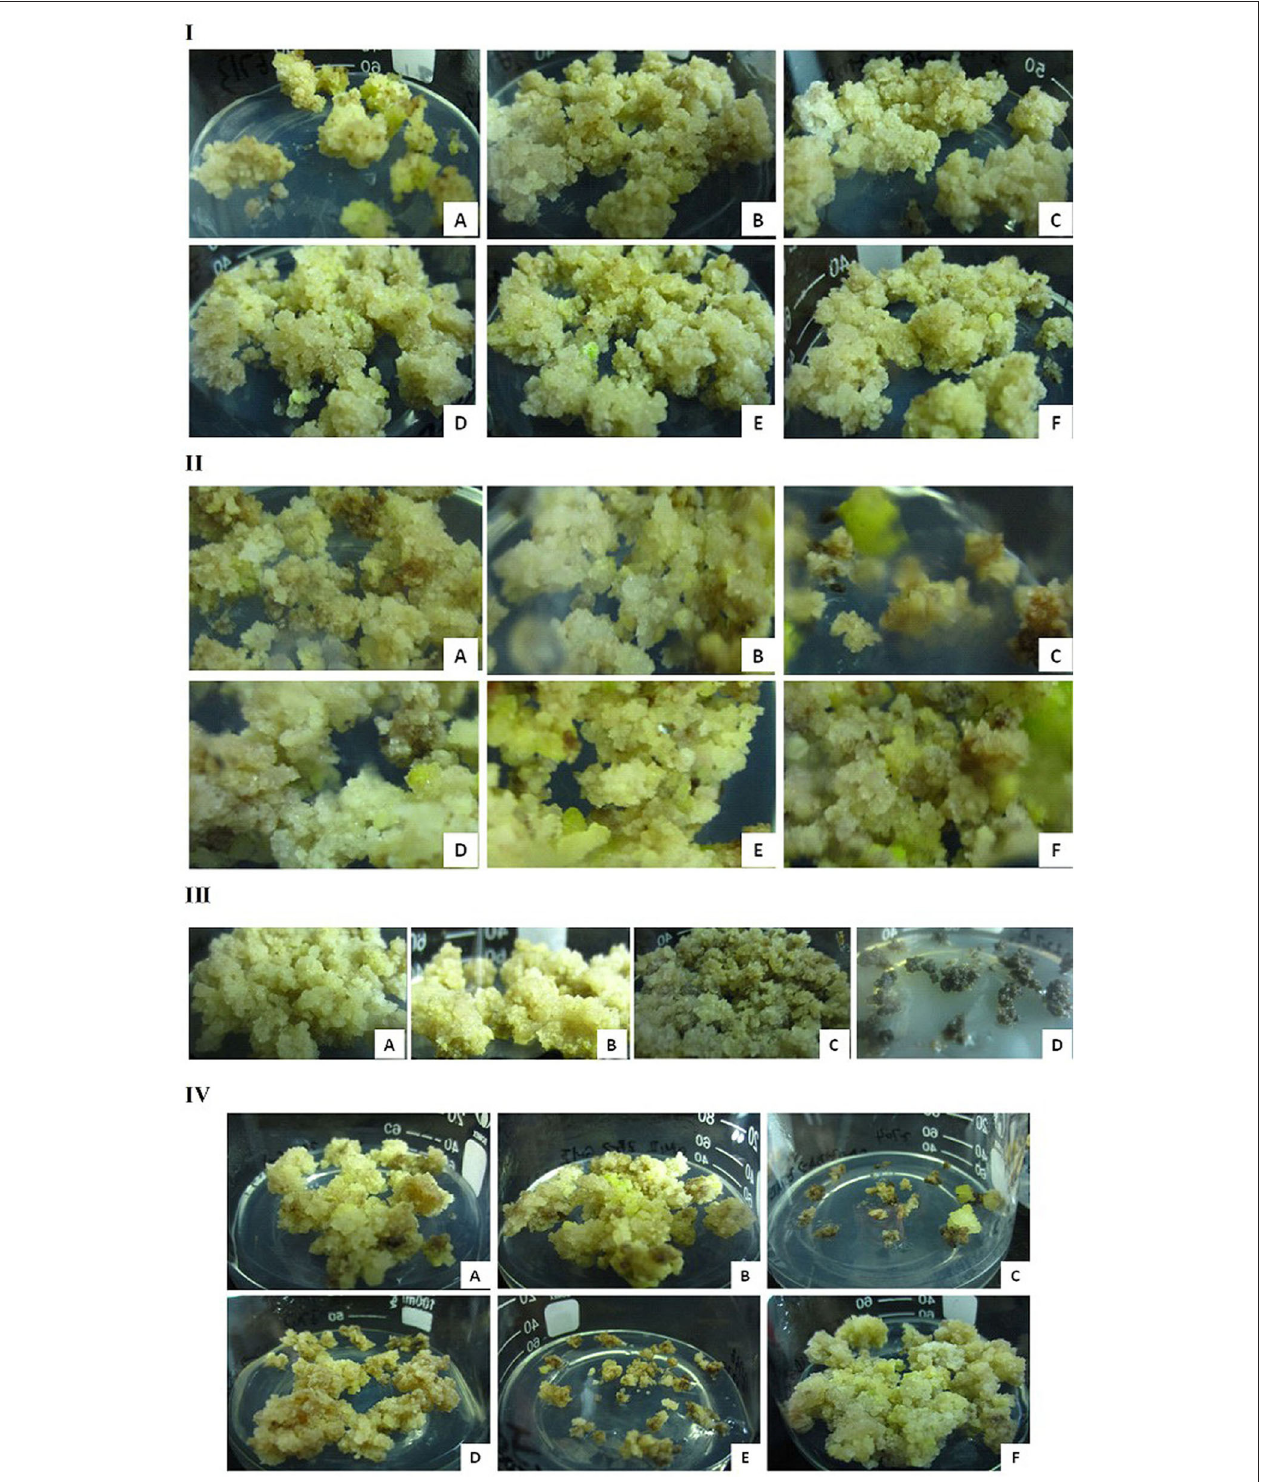
FIGURE 2 | Embryogenic callus initiation and proliferation of G. sturtianum . (I) IBA and KT, (A–F) EI1-EI6 corresponding to Table 1 ; (II) nitrogen source, (A–C) C1, C2, C3 corresponding to Supplementary Table 6 (D–F) EI7, E1, EI9 corresponding to Table 1 and Supplementary Table 6 ; (III) FeSO 4 , (A–D) C1, E4, E6, E7 corresponding to Supplementary Table 7 ; (IV) CuSO 4 , (A,B) C1 corresponding to Supplementary Table 7 ; (C–F) E7–E10 corresponding to Supplementary Table 7 .